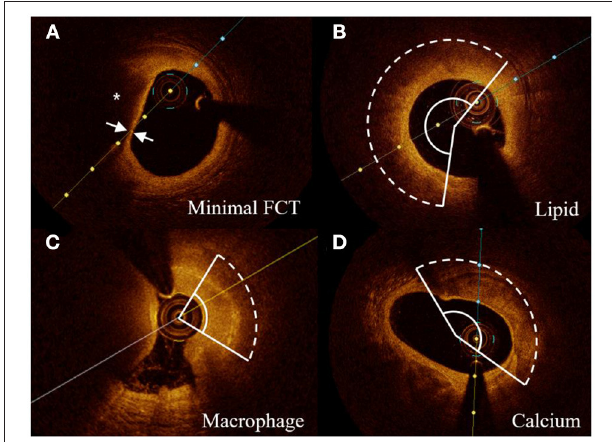
FIGURE 2 | Representative cross-sectional OCT images. (A) Lipid core (*) and minimal FCT were detected. (B–D) The arcs of lipid accumulation, macrophage infiltration, and calcium deposition were measured in representative cross-sectional OCT images, respectively. FCT indicates fibrous cap thickness.